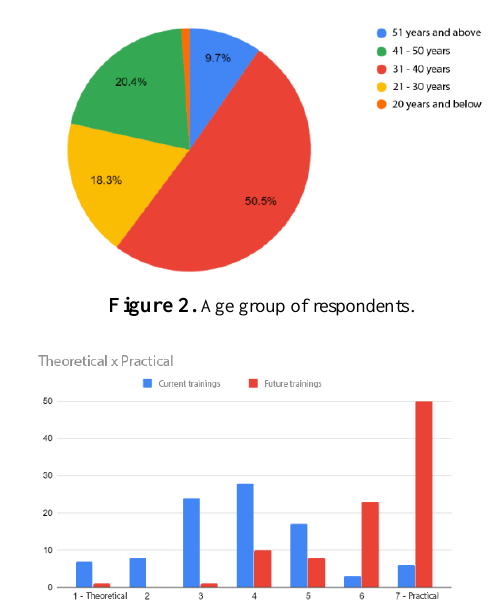
Figure 3. Vision of electricians and instructors about current and fu- ture trainings: theoretical x practical.